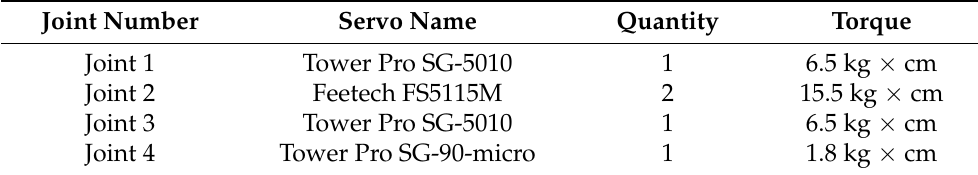
Table 1. Details of servo motors.